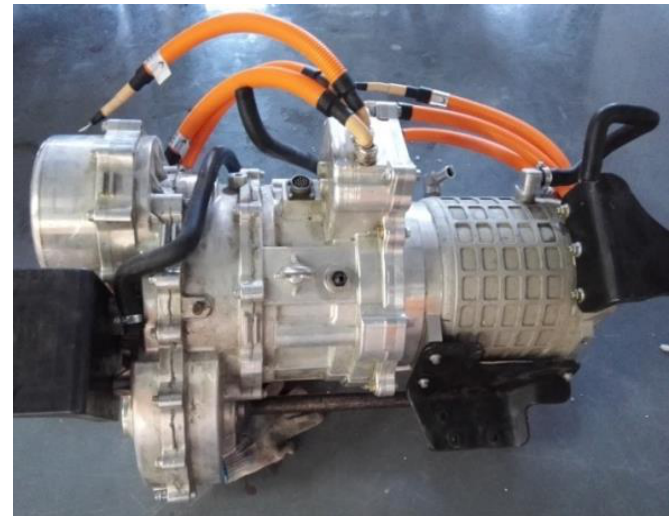
Figure 4. i-KERD in the FF/RR chassis.